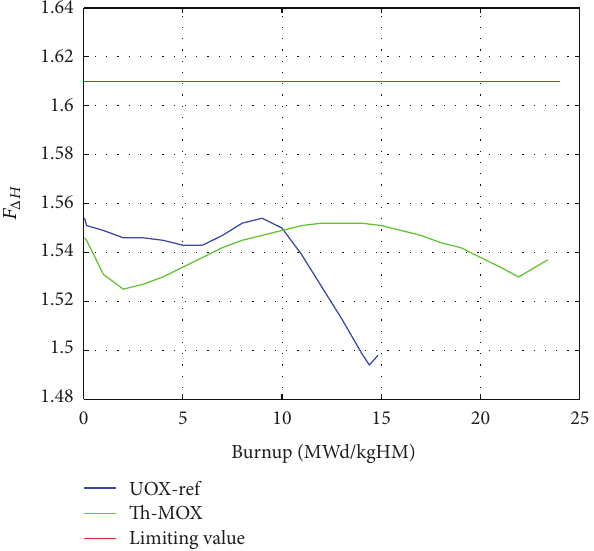
Figure 8: Boron concentration as a function of burnup. Table 1: Control rod and boron worth, their limits, and the calculated values for the Th-MOX and the reference UOX core. For the Th-MOX core, the boron used for reactivity control is enriched to 60% in 10 B instead of the usual 19.8% (natural isotopic composition), and stronger control rods are